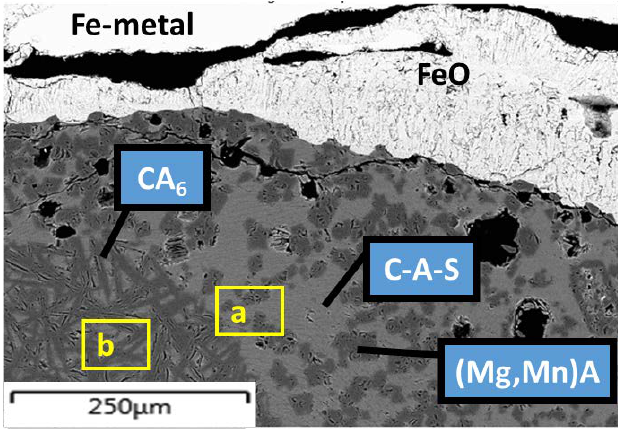
Figure 8. Microstructure of MagA-gun at the hot side.